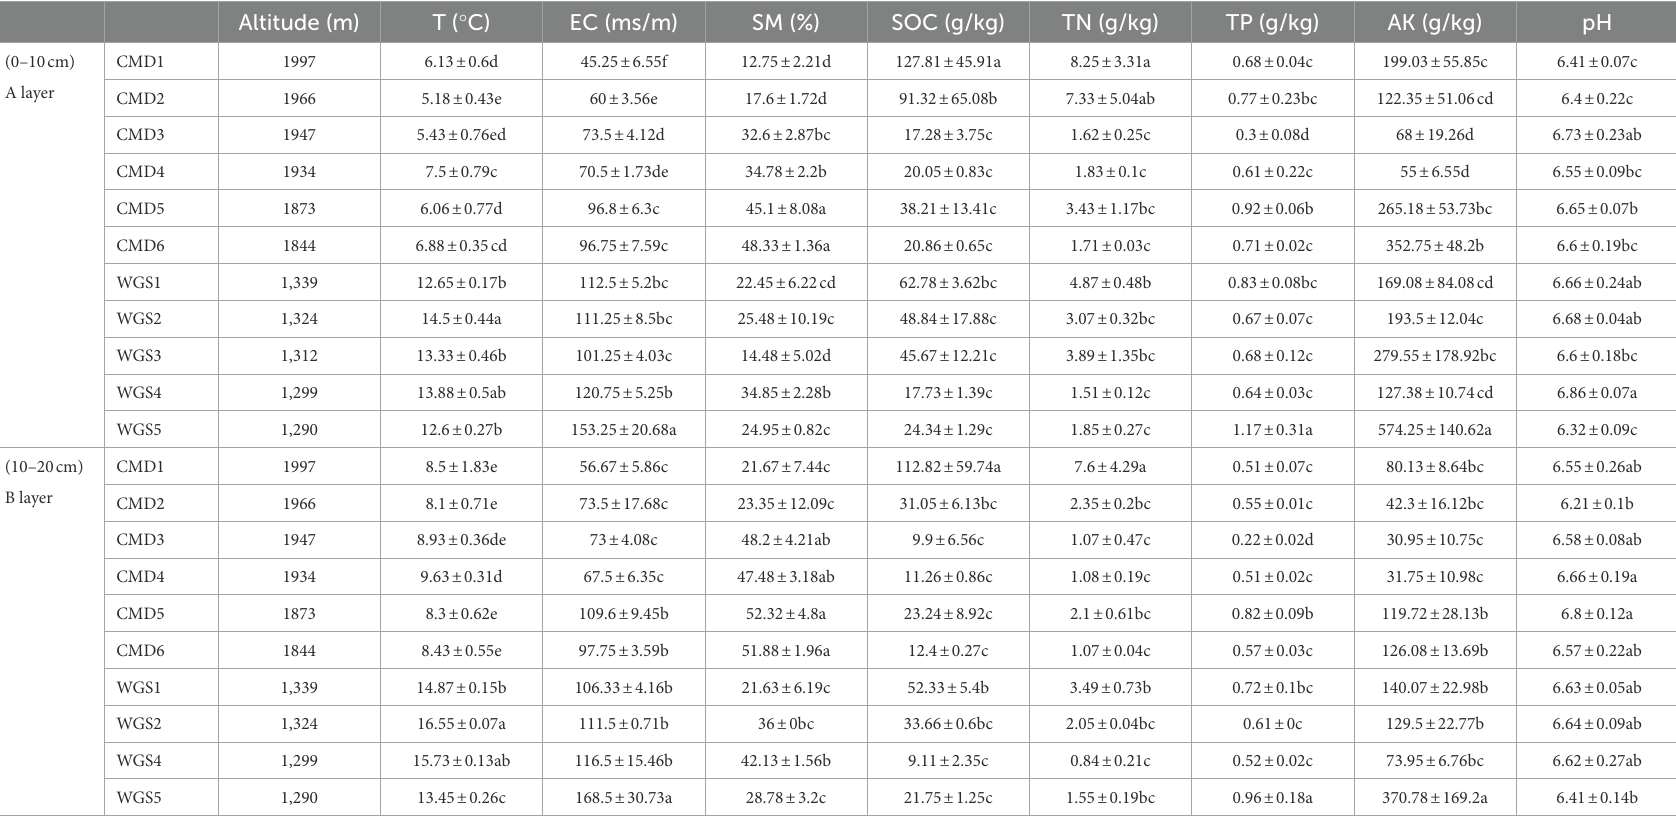
TABLE 1 Environmental parameters with soil depth changes along altitudinal gradients in karst graben basin of Yunnan-Kweichow Plateau. Altitude